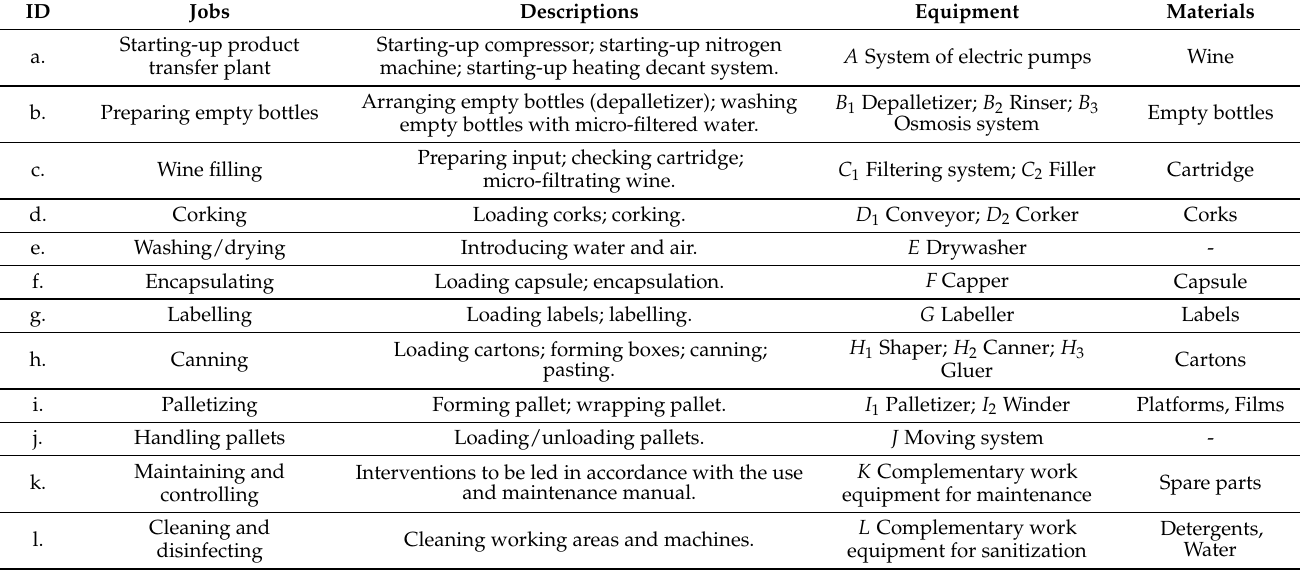
Table 1. Bottling process: jobs, descriptions, equipment,